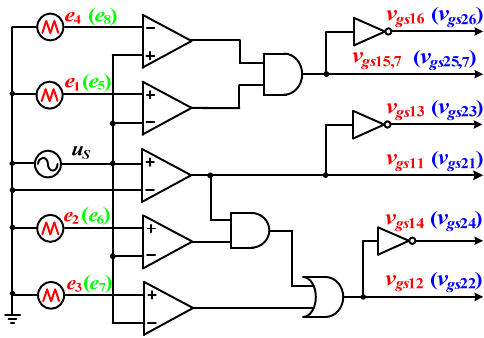
Figure 6. Modulating logic circuit of hybrid PWM.